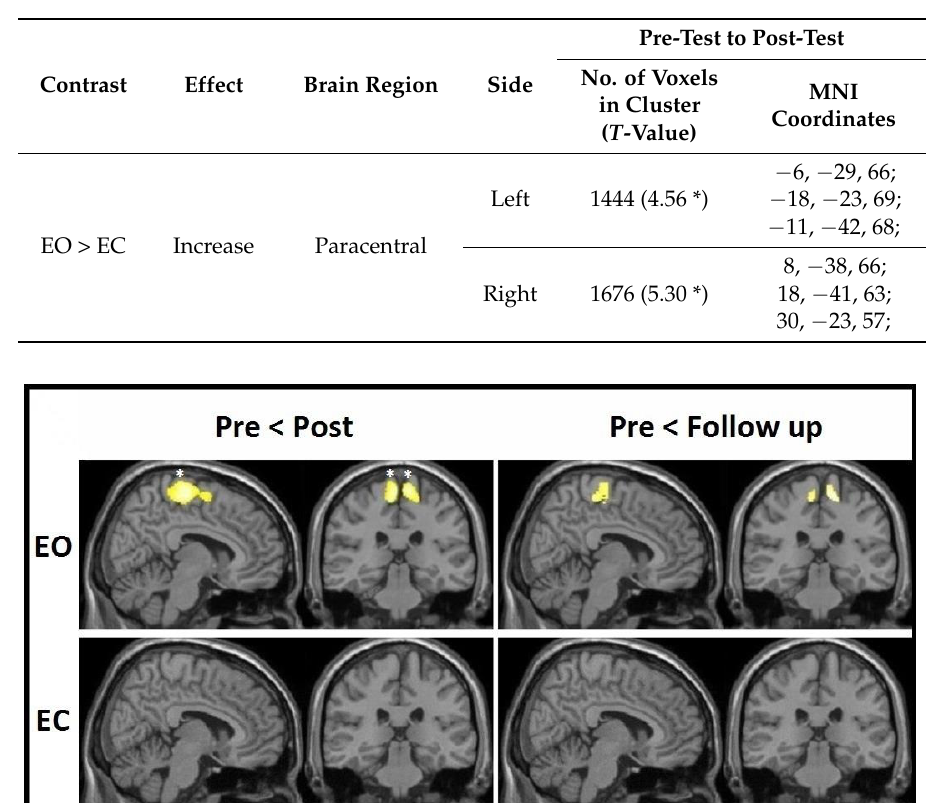
Table 3. MNI (Montreal Neurological Institute) coordinates ( x , y , z ) of VBM-detected gray matter